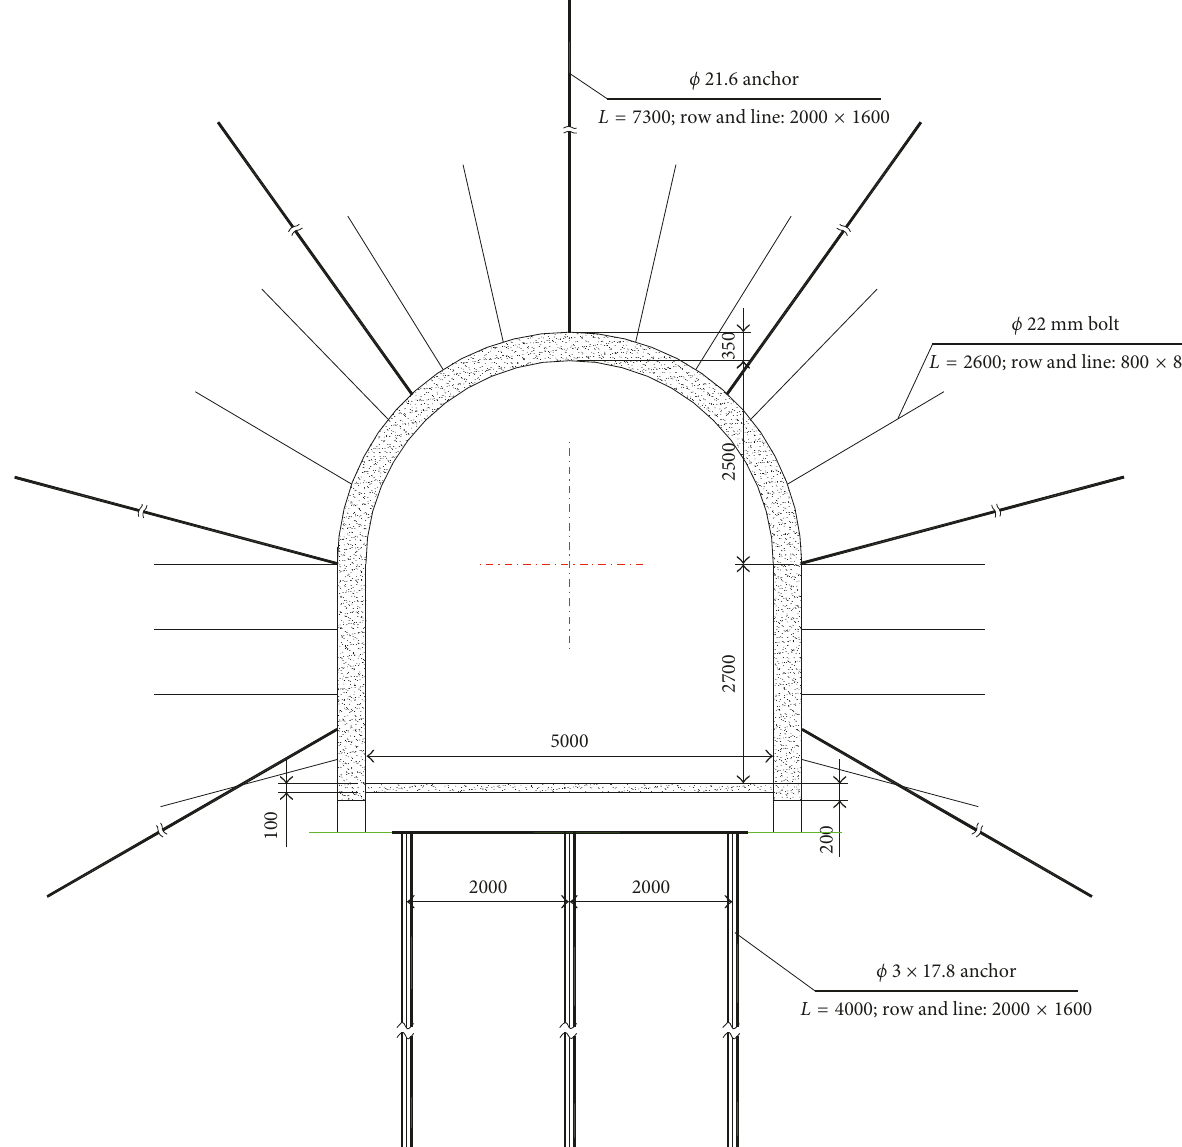
Figure 13: Bolt and anchor support program for the main drainage water pump house